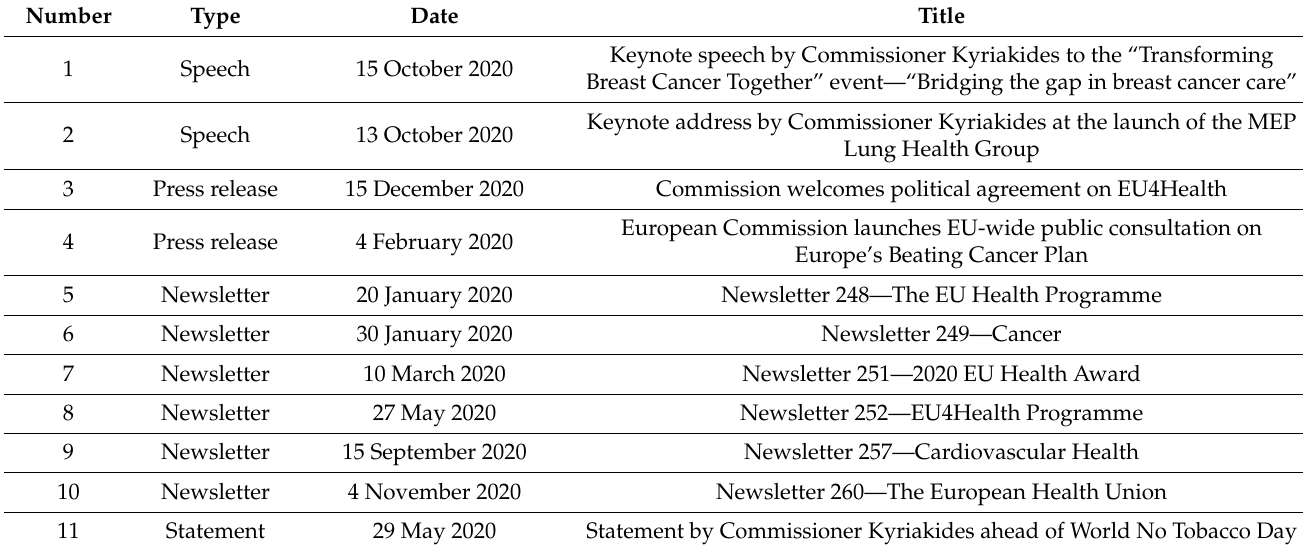
Table A1. Overview of included